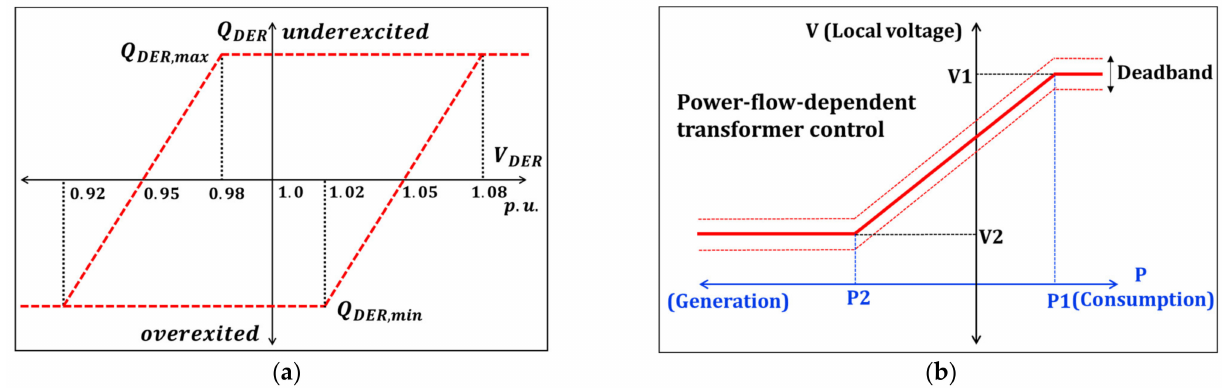
Figure 7. The Q(V) limitation characteristic ( a ) and the applied curve for the power-flow-dependent transformer control ( b